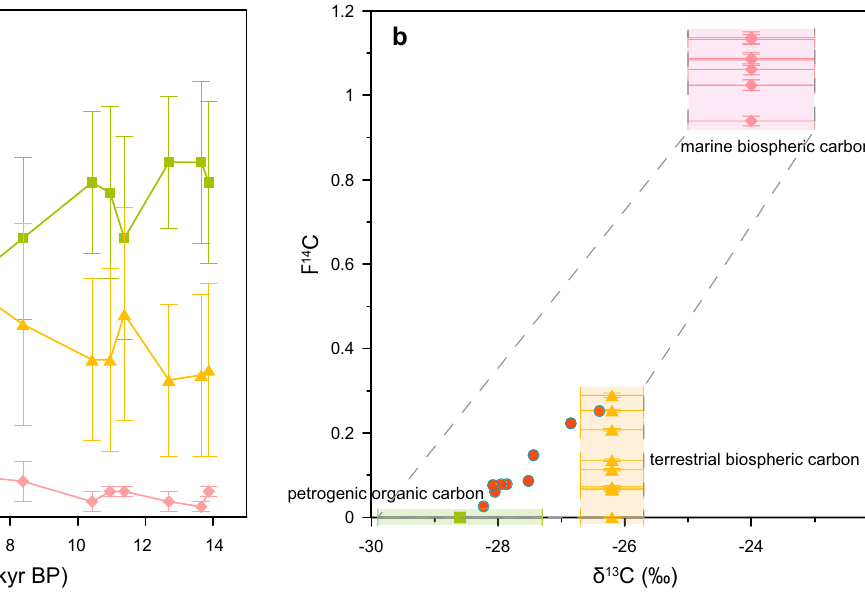
biospheric carbon (pink diamonds), terrestrial biospheric carbon (yellow trian- gles),andpetrogenicorganiccarbon(greensquares)usedinadual-isotopemixing model. Error bars represent standard